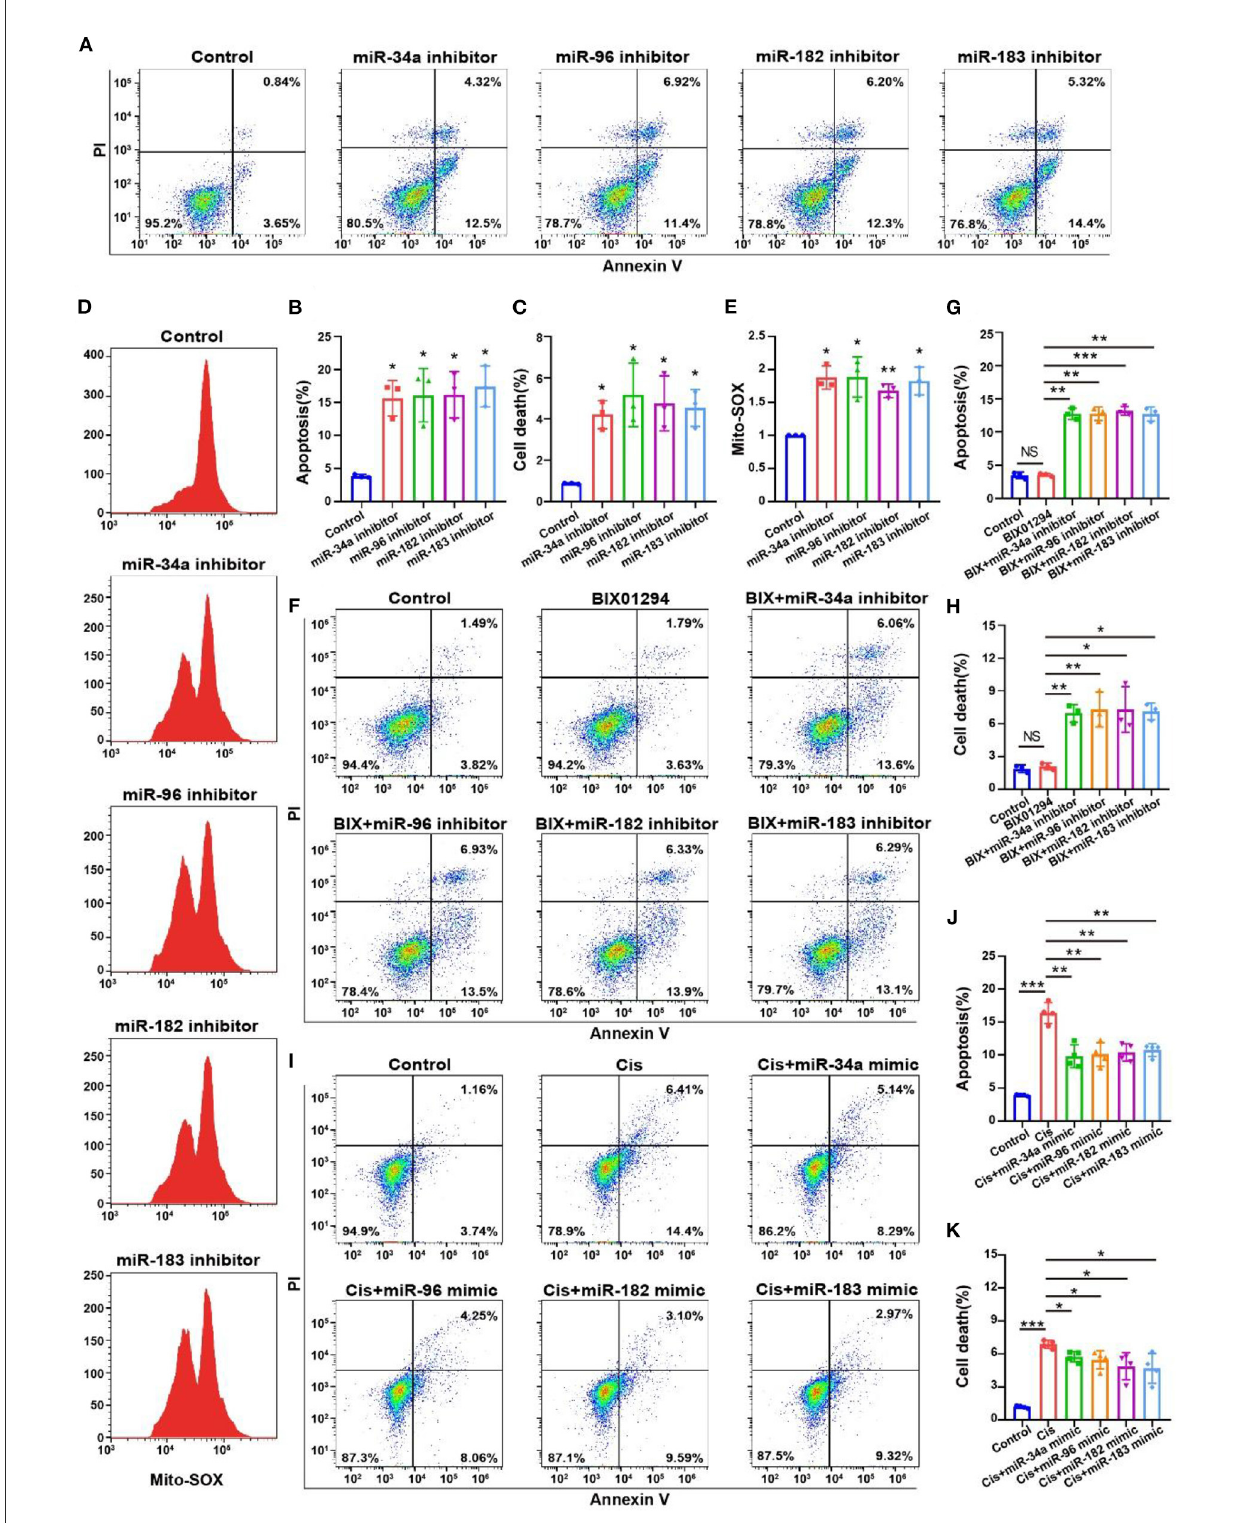
FIGURE8 Flow cytometry of apoptosis and ROS levels with miR-34a, miR-96, miR-182, and miR-183 regulation in the OC-1 cells. (A) Annexin V flow cytometry of apoptosis with miR-34a, miR-96, miR-182, and miR-183 inhibition. (B) Quantification of the apoptosis ratio in (A) . (C) Quantification of the cell death ratio in (A) . (D) Mito-SOX flow cytometry of cellular ROS level with miR-34a, miR-96, miR-182, and miR-183 inhibition. (E) Quantification of the data in (D) . (F) Annexin V flow cytometry of apoptosis after BIX01294 treatment with inhibiting miR-34a, miR-96, miR-182, and miR-183. (G) Quantification of the apoptosis ratio in (A) . (H) Quantification of the cell death ratio in (F) . (I) Annexin V flow cytometry of apoptosis after cisplatin treatment with miR-34a, miR-96, miR-182, and miR-183 mimics. (J) Quantification of the apoptosis ratio in (I) . (K) Quantification of the cell death ratio in (I) . * p < 0.05, ** p < 0.01, *** p <